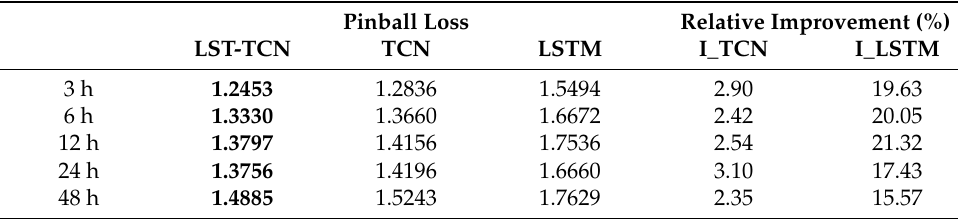
Table 2. The overall performance of each algorithm on ld2011_2014.